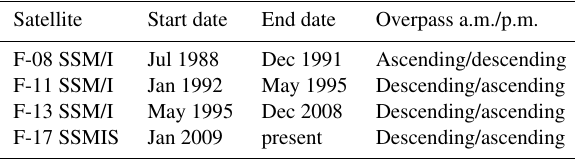
Table 1. Data periods for the different satellite passive microwave radiometers used for melt detection in this